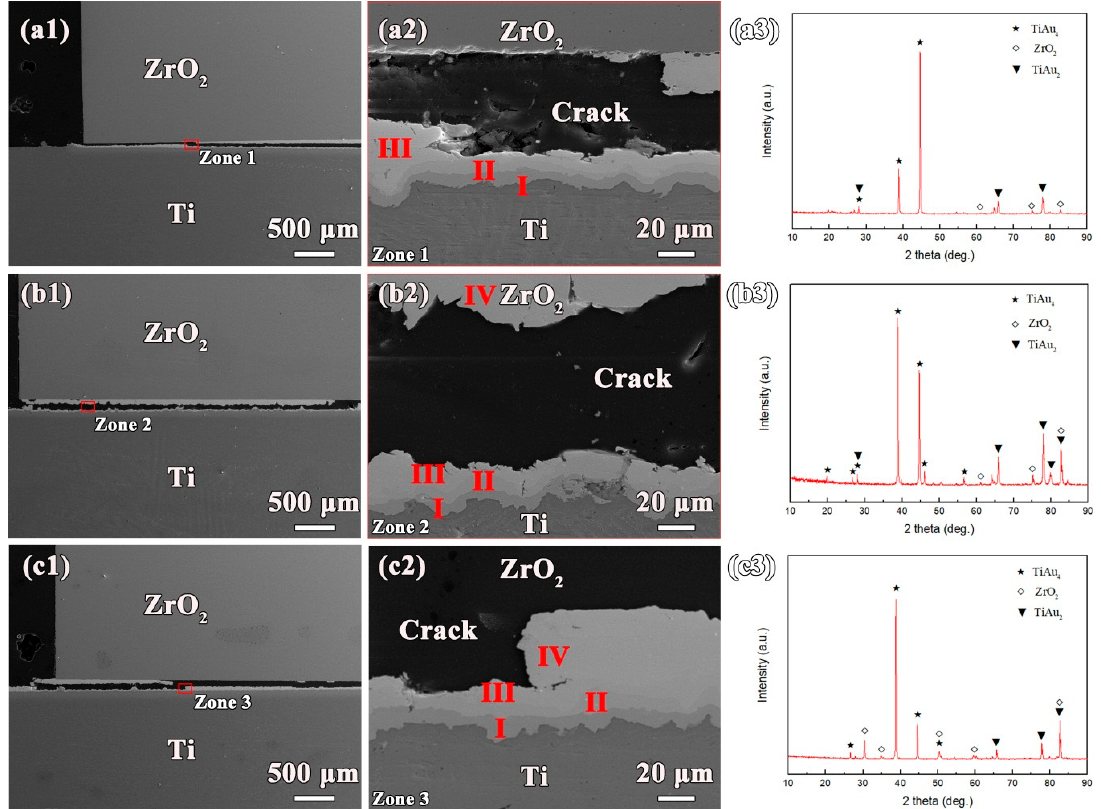
Figure 8. Fracture paths, high-magnification fractographs and XRD patterns of titanium/Au/ ZrO 2 joints brazed at different parameters after the shear test. ( a1–a3 ) 1110 °C for 10min, ( b1–b3 ) 1150 °C for 10 min, and ( c1–c3 ) 1150 °C for 30 min.